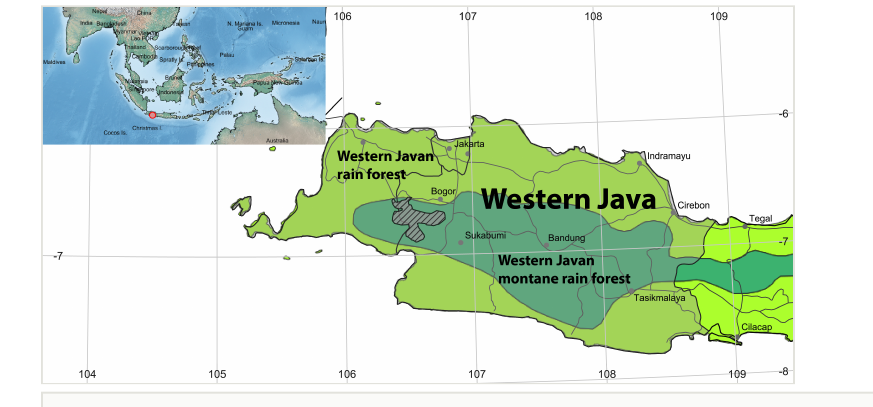
Map of Western Java showing the Halimun-Salak national Park (hatched). The study area is located in the Western Javan montane rain forest ecozone (dark green). Red dot in inset map shows the location of the study area in the Sundaland region. Map created with SimpleMappr (http://www.simplemappr.net).